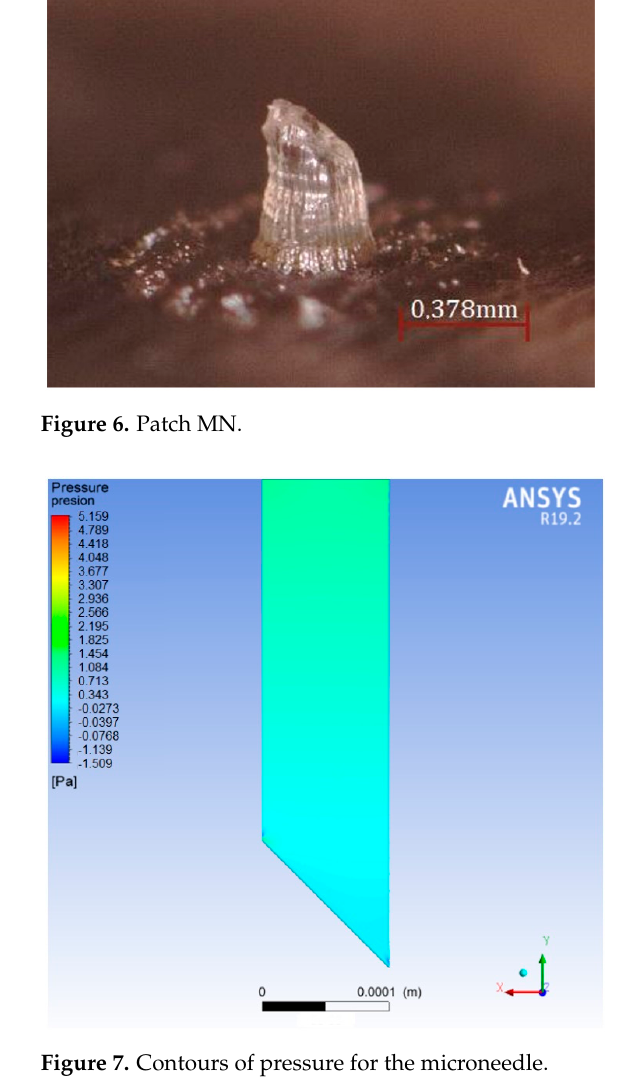
Figure 5. Von Misses Tensions of microneedle.